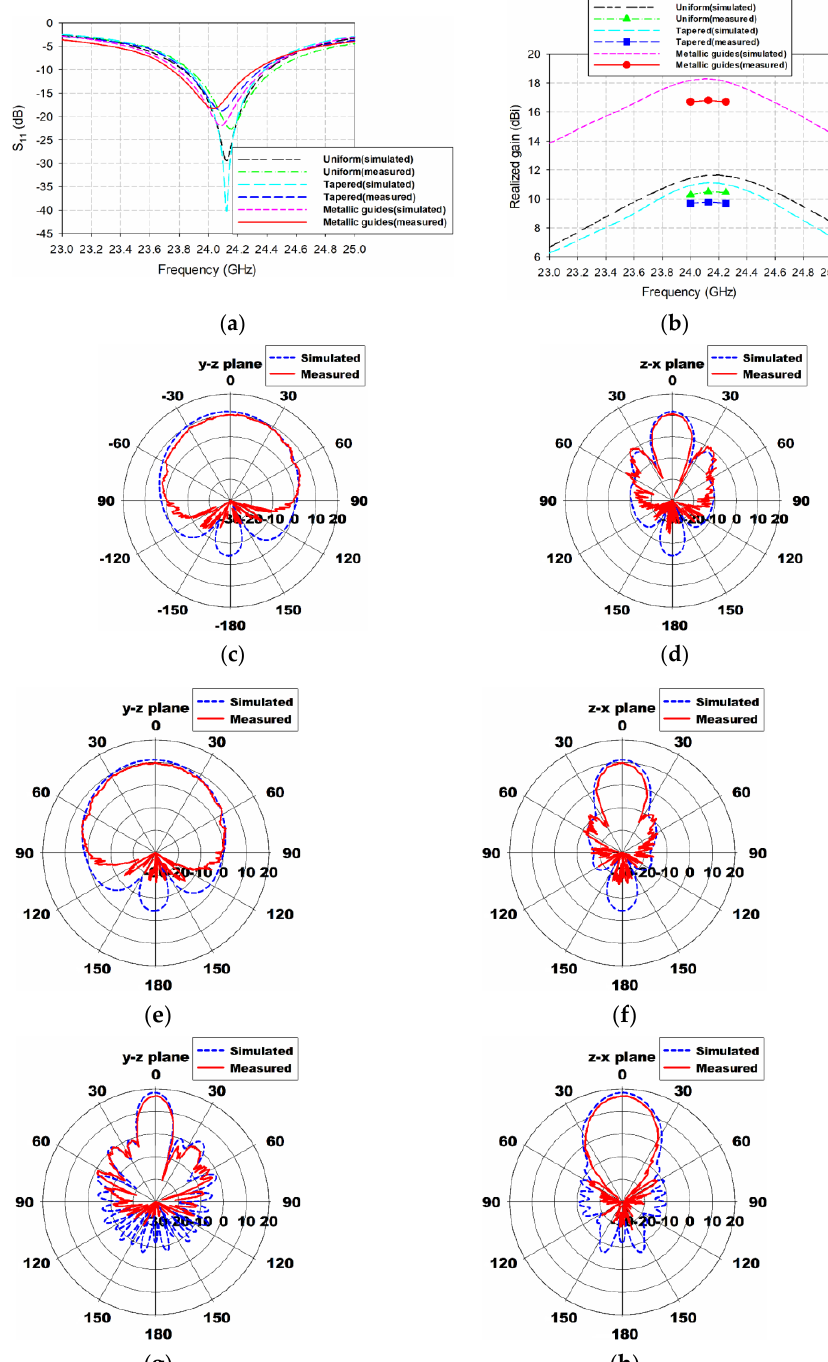
Figure 10. Performance comparison of the fabricated antennas: ( a ) input reflection coefficients, ( b ) realized gain, ( c ) y–z plane radiation patterns at 24.125 GHz for the 4 × 1 array antenna using uniform power distribution, ( d ) z–x plane radiation patterns at 24.125 GHz for the 4 × 1 array antenna using uniform power distribution, ( e ) y–z plane radiation patterns at 24.125 GHz for the 4 × 1 array antenna using tapered power distribution, ( f ) z–x plane radiation patterns at 24.125 GHz for the 4 × 1 array antenna using tapered power distribution, ( g ) y–z plane radiation patterns at 24.125 GHz for the 4 × 1 array antenna using tapered power distribution appended with two metallic plates, and ( h ) z–x plane radiation patterns at 24.125 GHz for the 4 × 1 array antenna using tapered power distribution appended with two metallic plates.